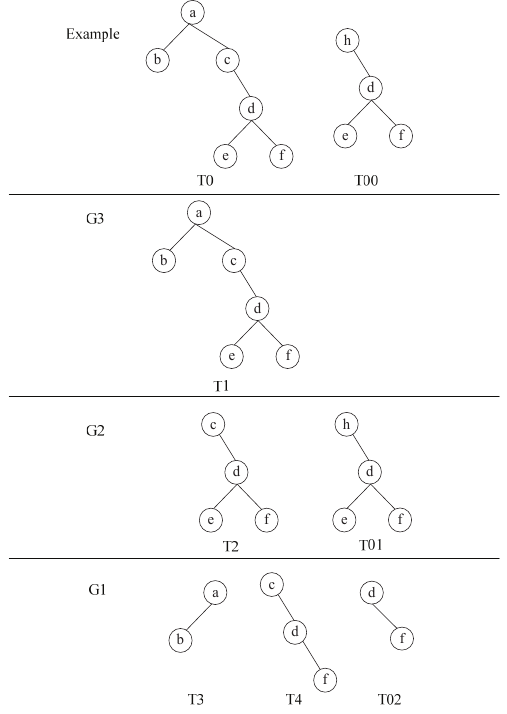
Figure 2. An example of weight tree